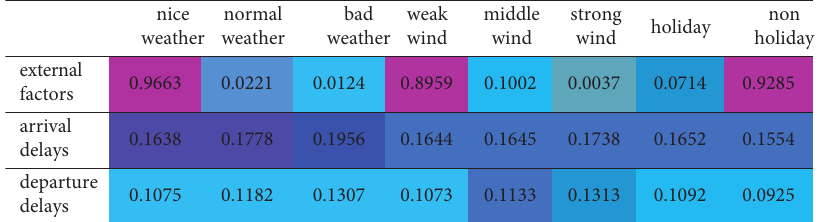
Table 5: Different external factors on the change of departure delay rate and arrival delay